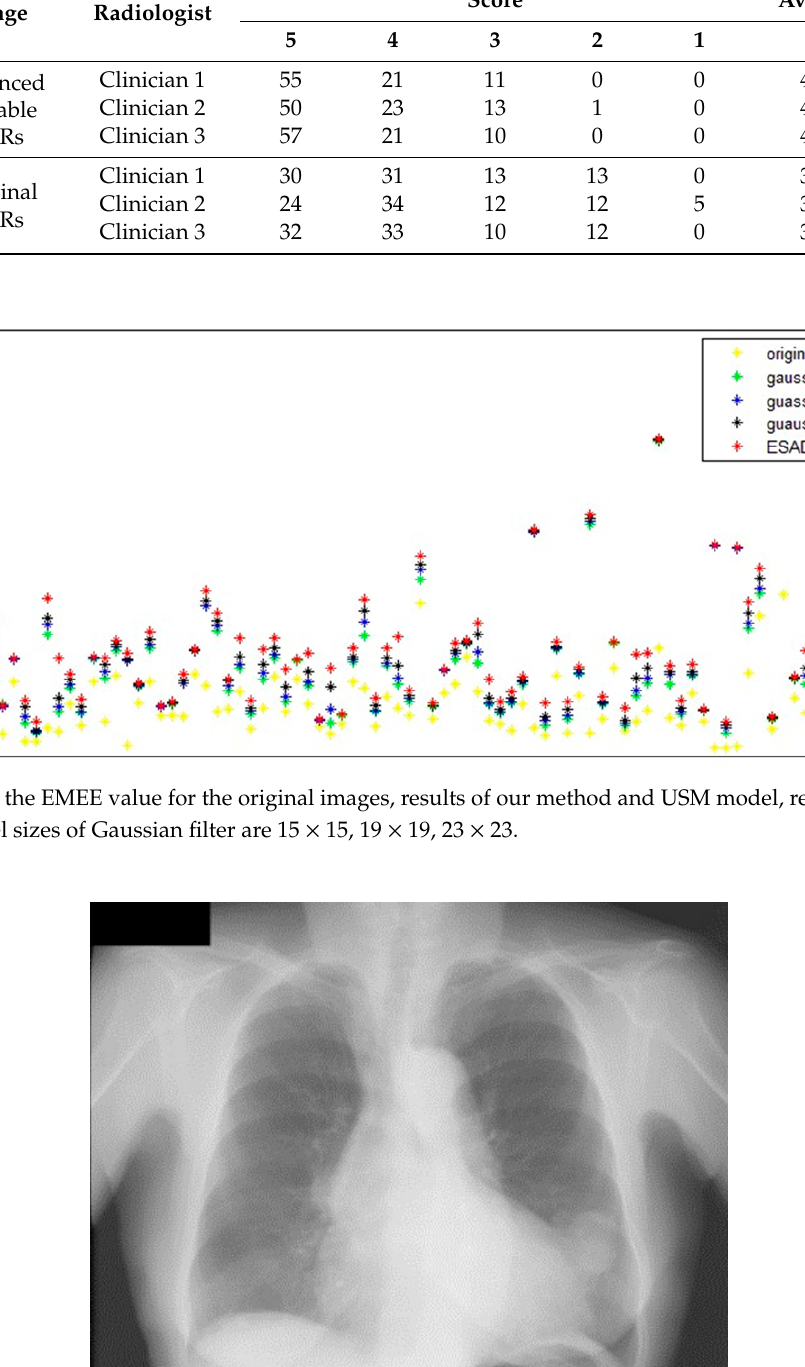
Figure 8. Unsharp masks for image of Figure 7. Green circles are the stomach area, ( a ) mask from Gaussian difussion; ( b ) mask from RAD. 4. Discussion We presented an image enhancement method for CXRs in ICU by using RAD-based USM. It is acknowledged that several factors must be considered when the comparisons are made. Based on previous results, we conclude that our RAD-based USM method improves the enhancement of line structures such as endotreacheal tube (ET), feeding tube (FT), and nasogastic tube (NT) in CXRs. We also notice that it is difficult to get the optimized parameter in our method, because portable CXRs use different dose setting, positioning etc. The interpretation of CXRs is usually challenging, especially for the inexperienced radiologists. Therefore, we developed an improved RAD-based USM to enhance the image and improved their